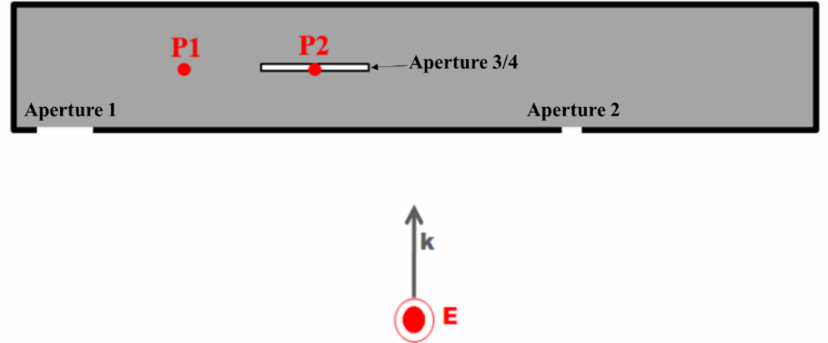
Figure 6. Measurement and simulation positions P1 and